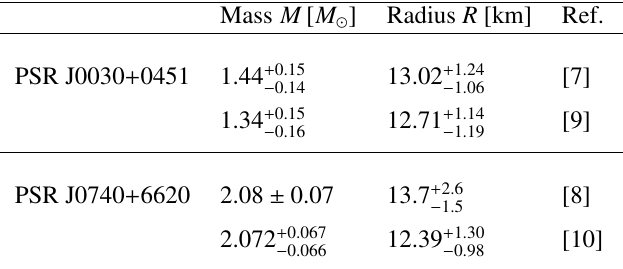
Table 1. Masses of two neutron stars together with radii inferrred from NICER measurements at